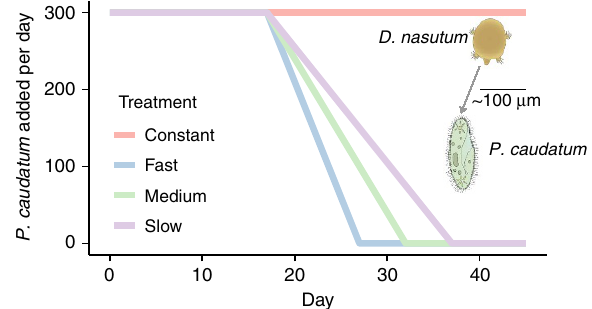
Figure 1 | Experimental declines in prey availability. Populations of the predatory ciliate Didinium nasutum were fed B 300 individuals of the prey species Paramecium caudatum per day for the first 18 days of the experiment. From day 18 onwards, four experimental treatments were initiated where the number of P. caudatum fed to the D. nasutum populations was manipulated. Vector images of Didinium and Paramecium were reproduced with permission from originals by Tracey Saxby, IAN Image Library (ian.umces.edu/imagelibrary). NATURE COMMUNICATIONS|7:10984|DOI: